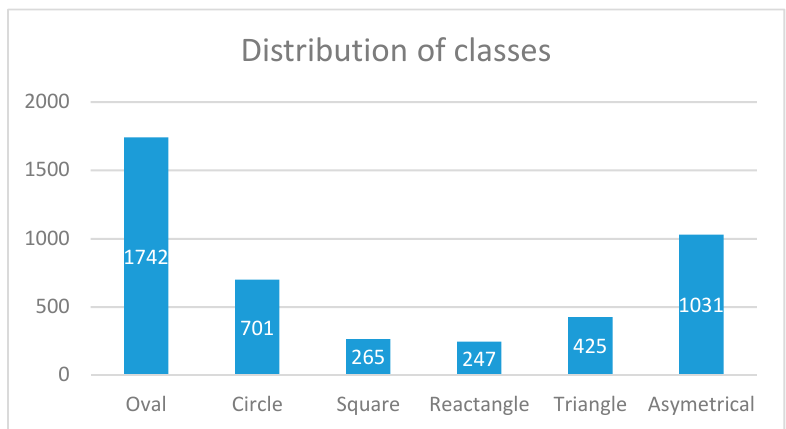
Figure 2. Expert-classified amber gemstones before processing.